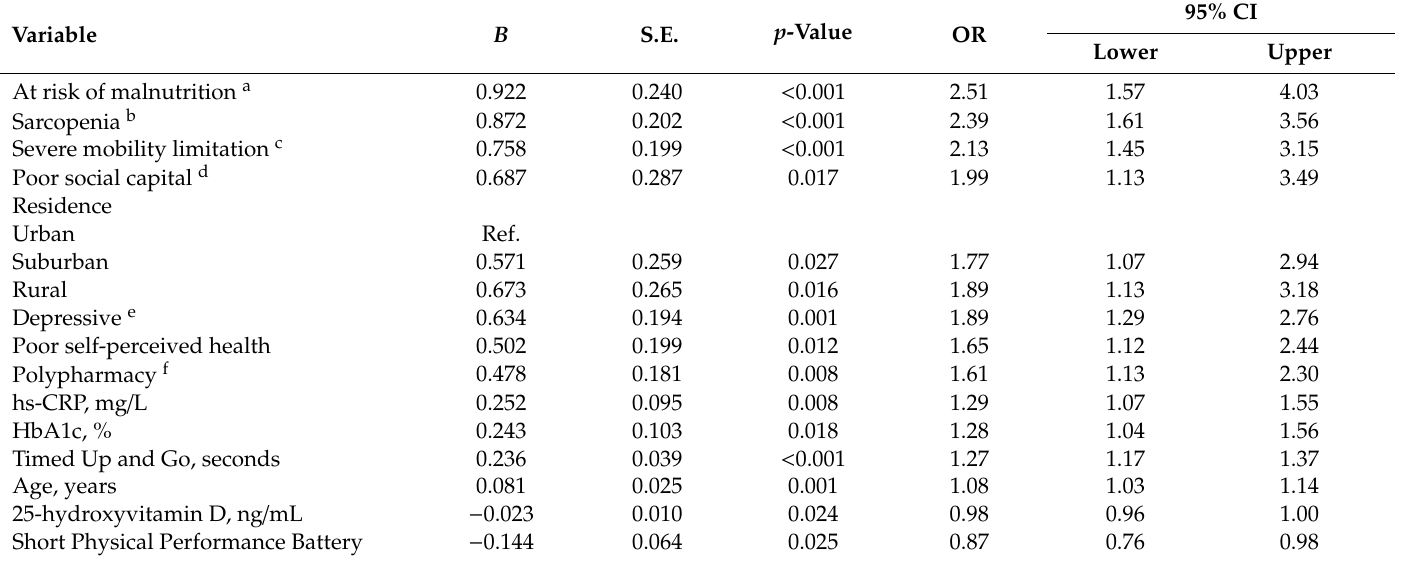
Table 4. Risk factors associated with physical frailty in the final forward logistic regression models (unstandardized sample). Variable B S.E. p -Value OR